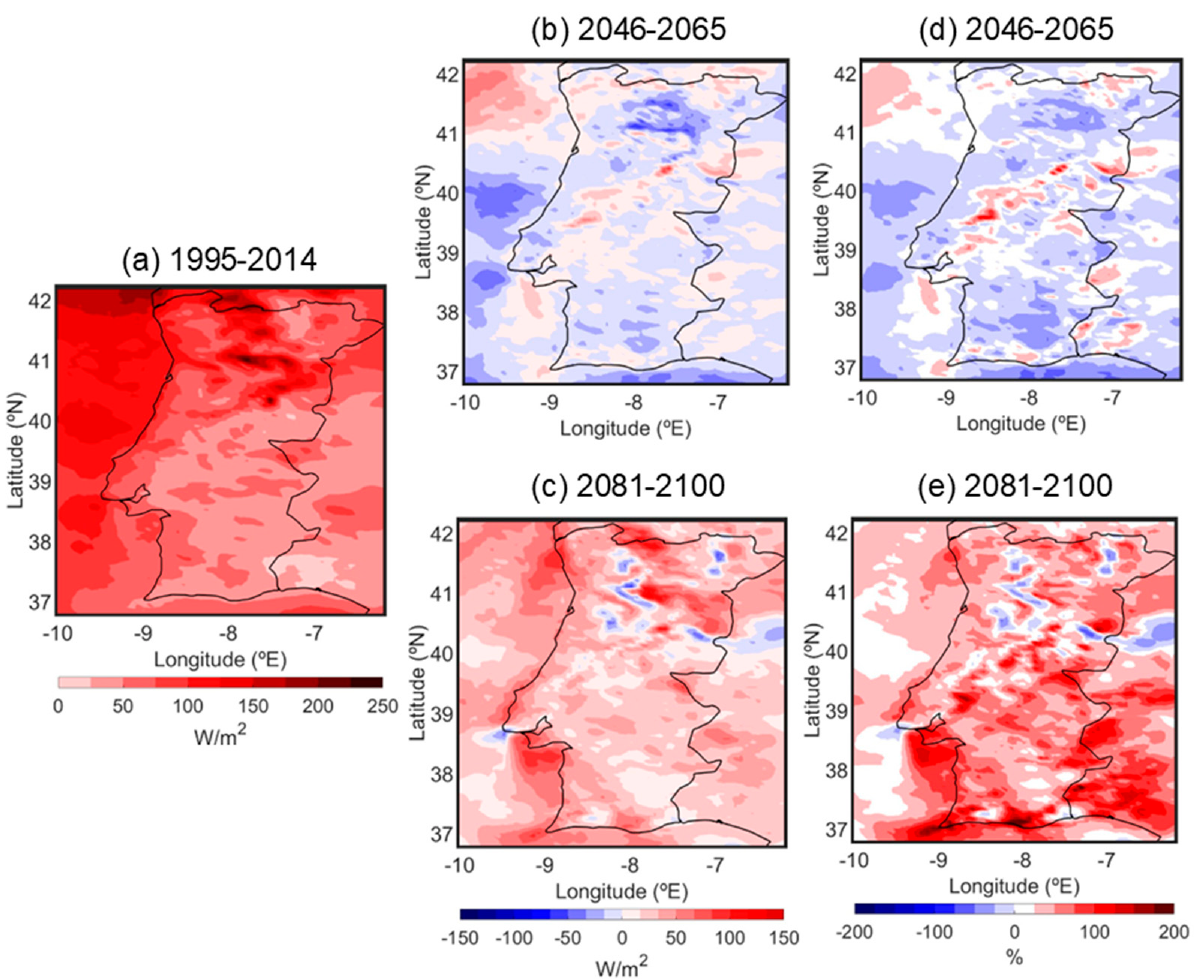
Figure 8. The 100 m WPD inter-annual variability (75th percentile minus 25th percentile of annual mean values) for 1995–2014 (( a ), in W/m 2 ), and corresponding absolute (middle column, in W/m 2 ) and relative (right column, in %) anomalies for ( b , d ) 2046–2065 and ( c,e ) 2081–2100, under SSP5-8.5.